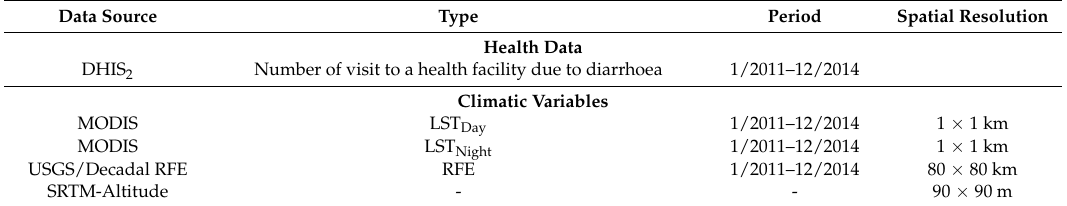
Table 1. Health data and remote sensing data sources, including reporting period and spatial